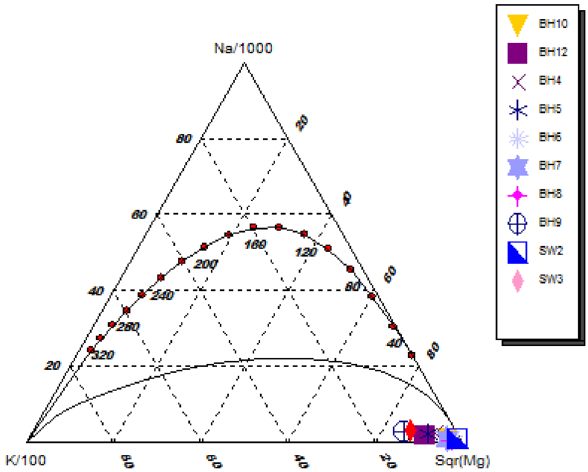
Fig. 8 Rock-water equilibrium of the samples plotted on Giggenbach diagram